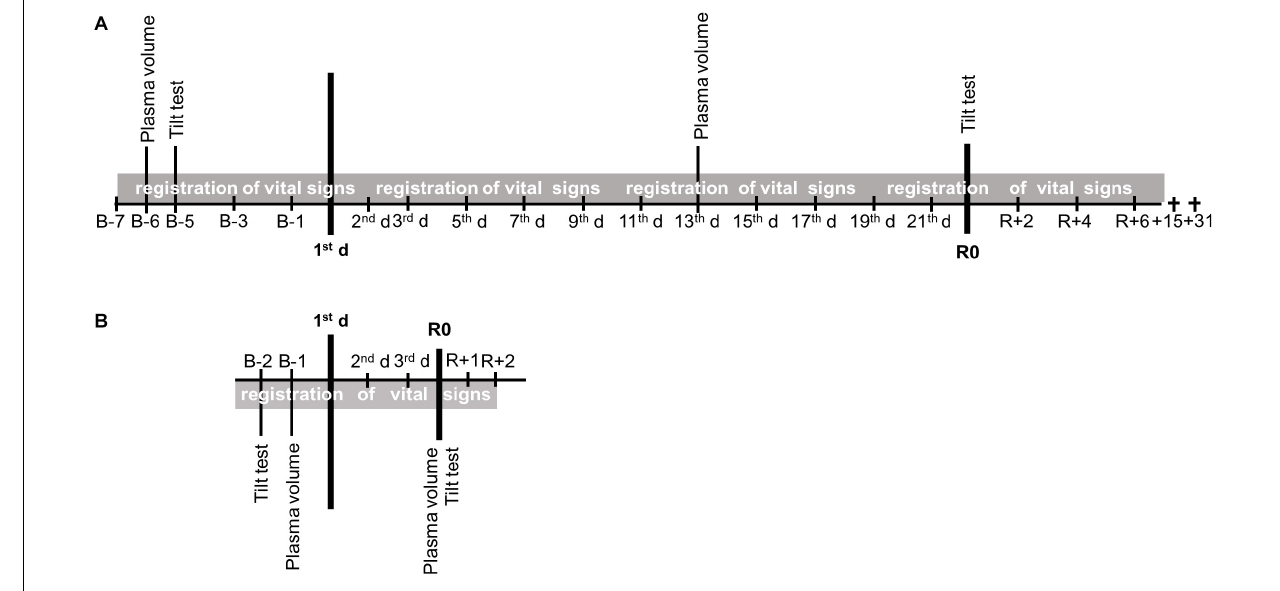
When comparing within each model, one-way repeated measures ANOVA was applied. Orthostatic tolerance time was tested by ordinary two-way ANOVA (tilt × models). Three-way ANOVA (time × models × tilt) was used for the hemodynamic parameters and HRV tilt test data. Bonferroni post hoc test was applied for all comparisons, the values of which are given in the text when the differences are significant. The significance level was set at α =